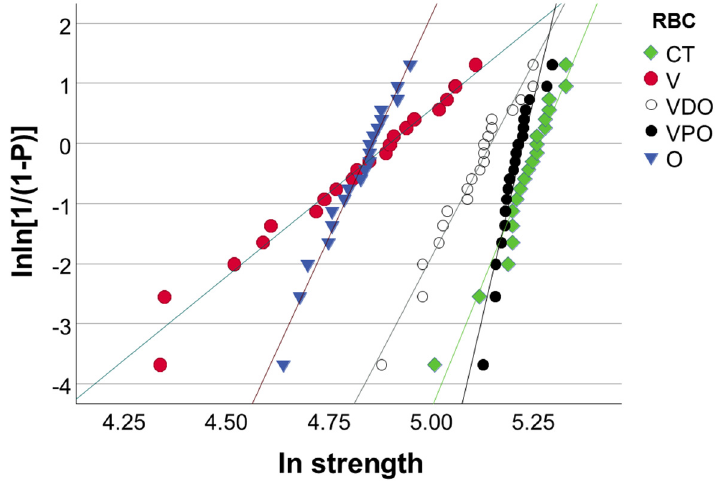
Figure 5. Example of a Weibull plot representing the empirical cumulative distribution function of strength data at 24 h post-curing. Linear regression was used to numerically assess the goodness-of-fit and estimate the parameters of the Weibull distribution, as described in Table 2. Table 2. Weibull parameters arranged in ascending order of Weibull parameter m (with standard error SE) within each aging category. R squared (R 2 ) values are also